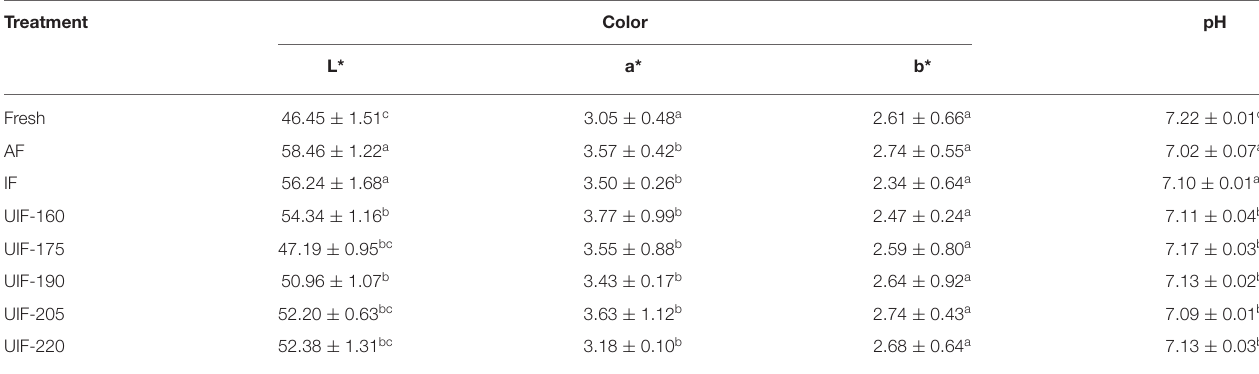
TABLE 2 | Influence of different freezing treatments on the color and pH of large yellow croaker. Treatment